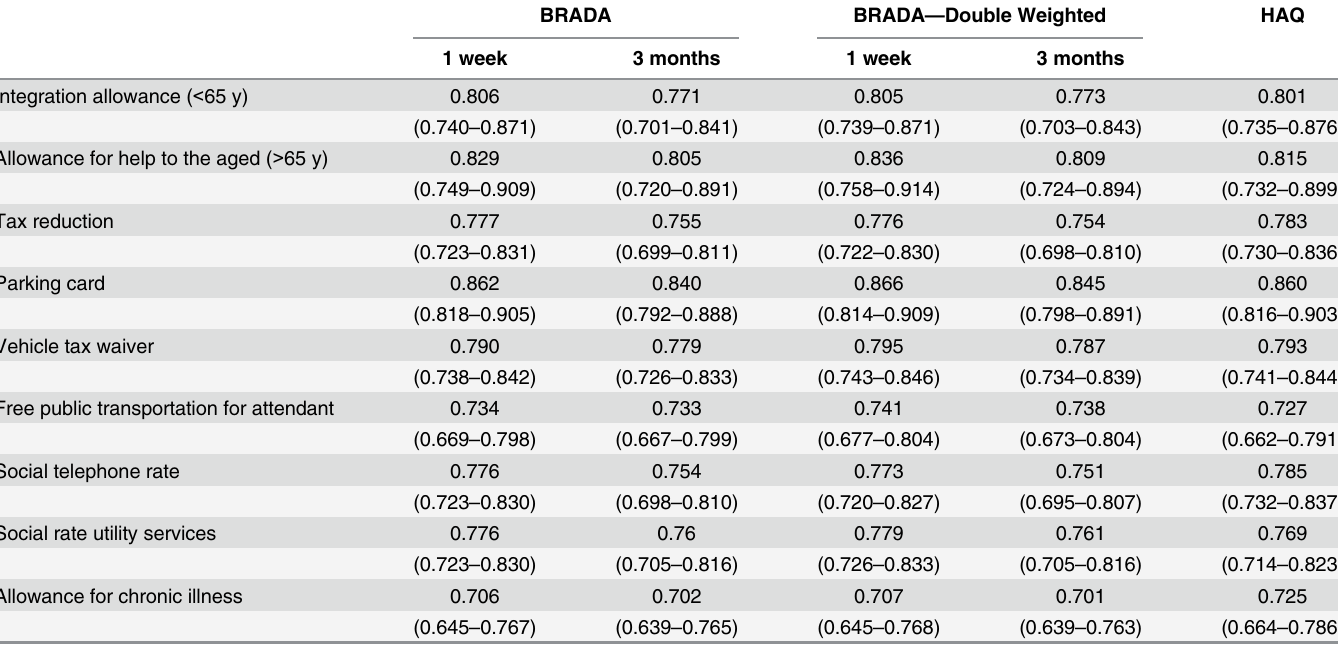
Table 4. Area under the curve of Receiver operator curves comparing the performance of BRADA and HAQ scores in predicting the need for sup- port measures in patients with